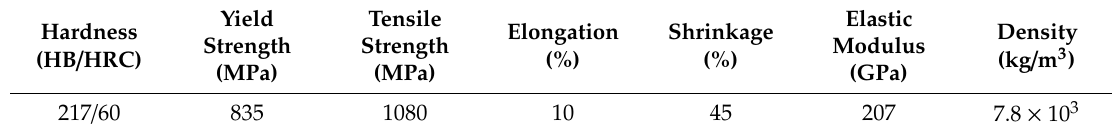
Table 4. Physical properties of